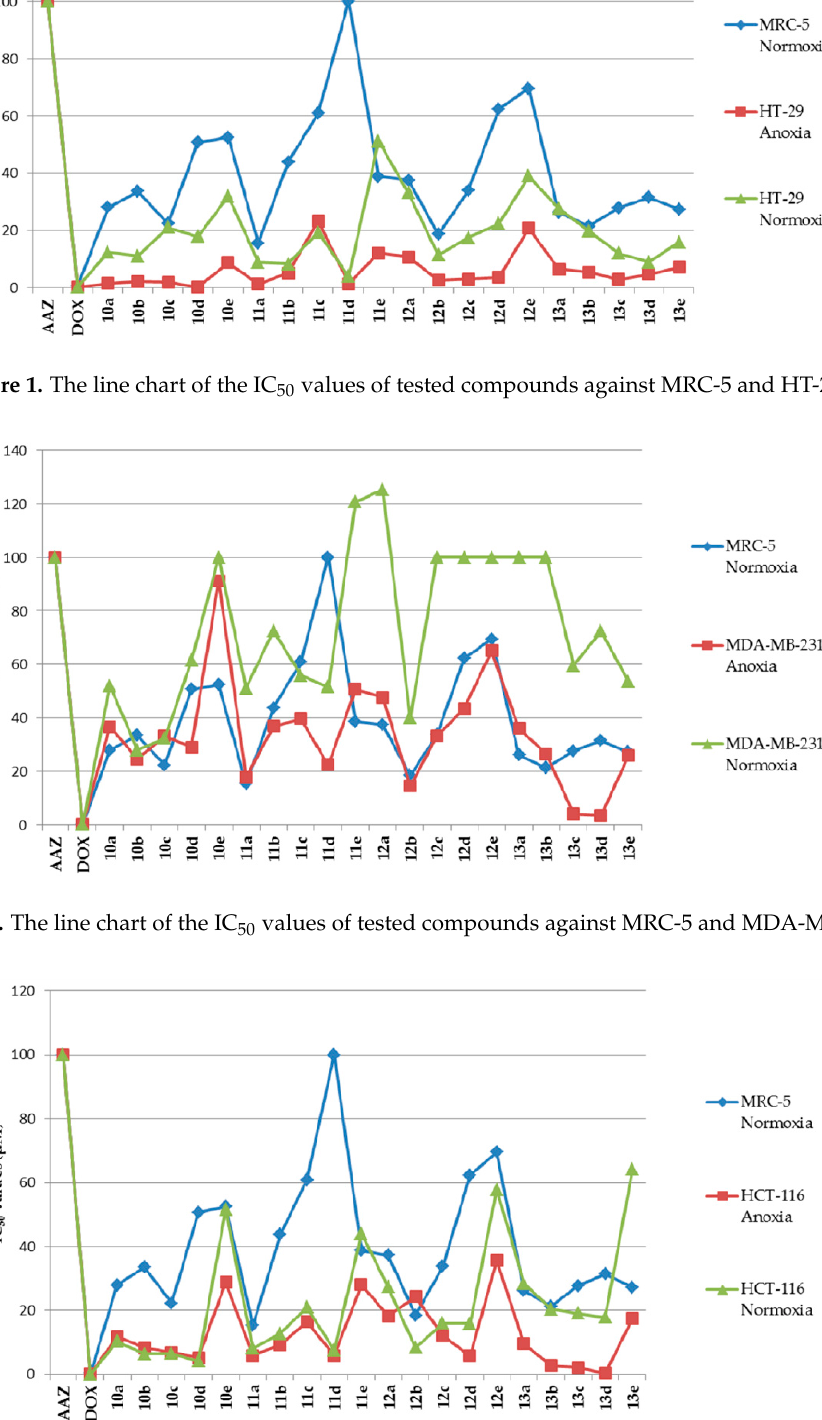
Figure 3. The line chart of the IC 50 values of tested compounds against MRC-5 and HCT-116.